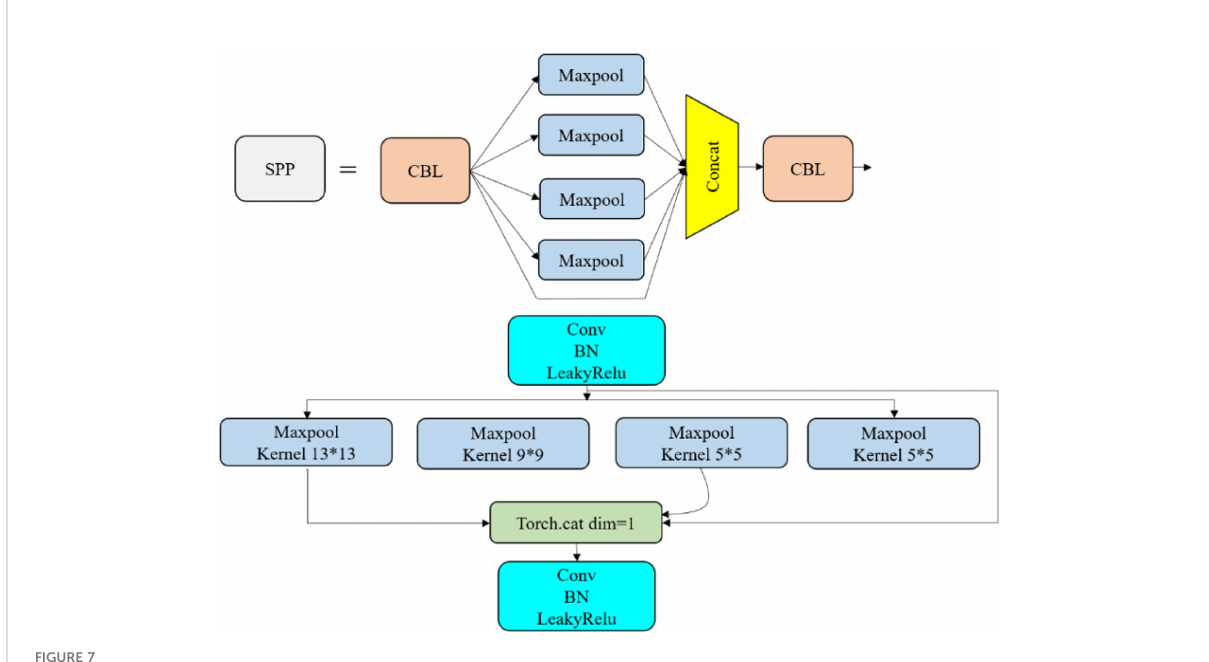
FIGURE 7 Pooling layer improvement structure.